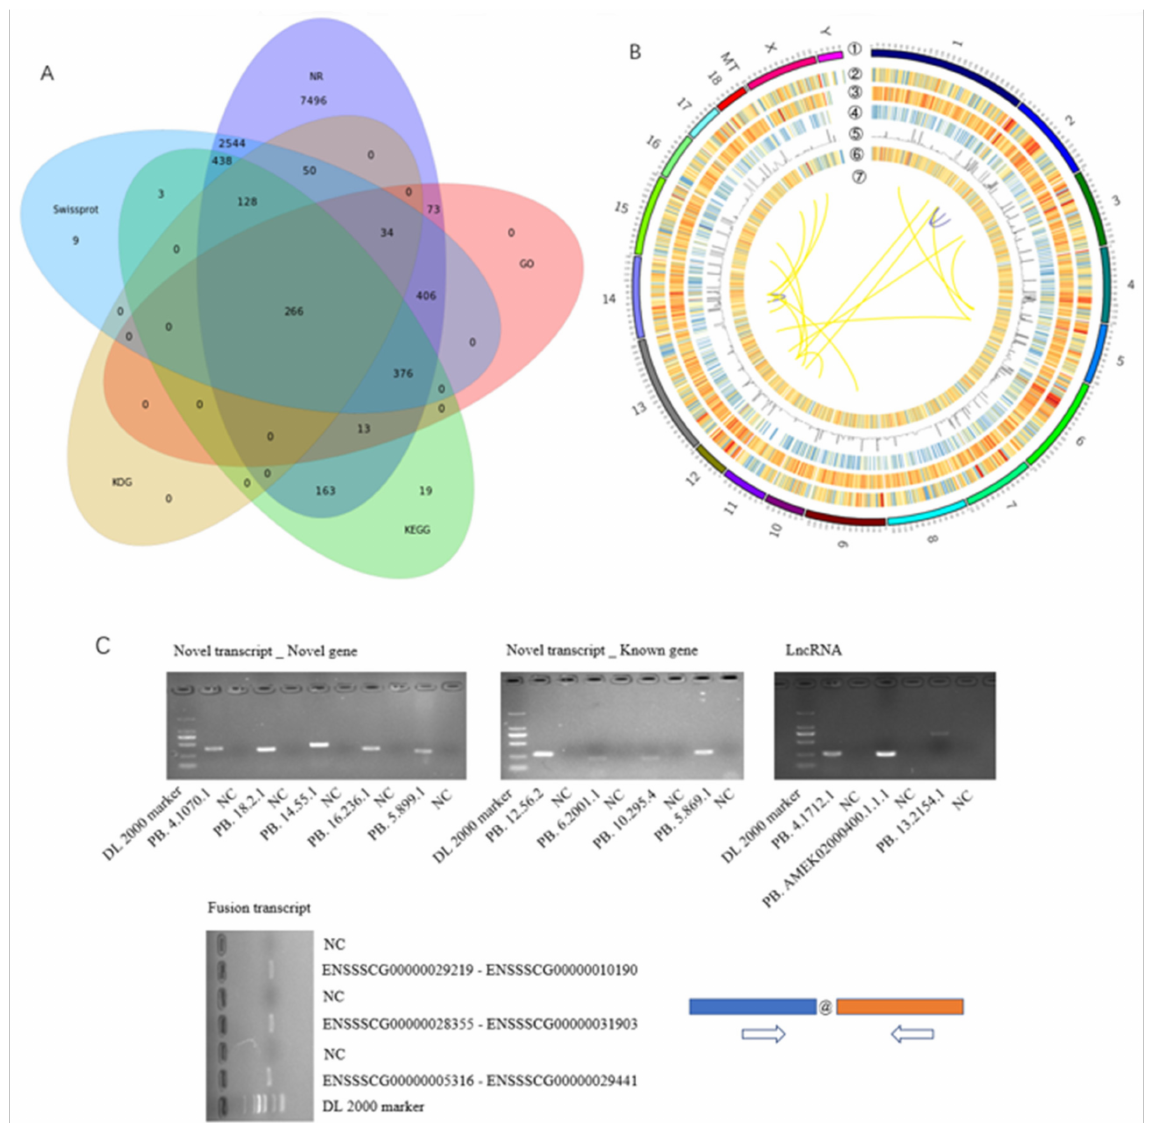
Figure 2. Identification of novel genes by Iso-seq analysis. ( A ) Venn diagram depicting novel protein- coding isoforms among NR, GO, KO, KOG, and Swiss-Prot databases; ( B ) CIRCOS visualization of data identified at the chromosomal level. 1 (cid:13) Pig chromosomes; 2 (cid:13) distribution of gene in reference genome; 3 (cid:13) distribution of gene identified by Iso-seq; 4 (cid:13) transcript distribution; 5 (cid:13) alternative splicing event distribution; 6 (cid:13) lncRNA distribution; 7 (cid:13) fusion transcripts: inter-chromosome (yellow), intro-chromosome (blue); ( C ) validation of novel isoforms with RT-PCR. Arrow, primer position; @, junction of two genes; NC, negative